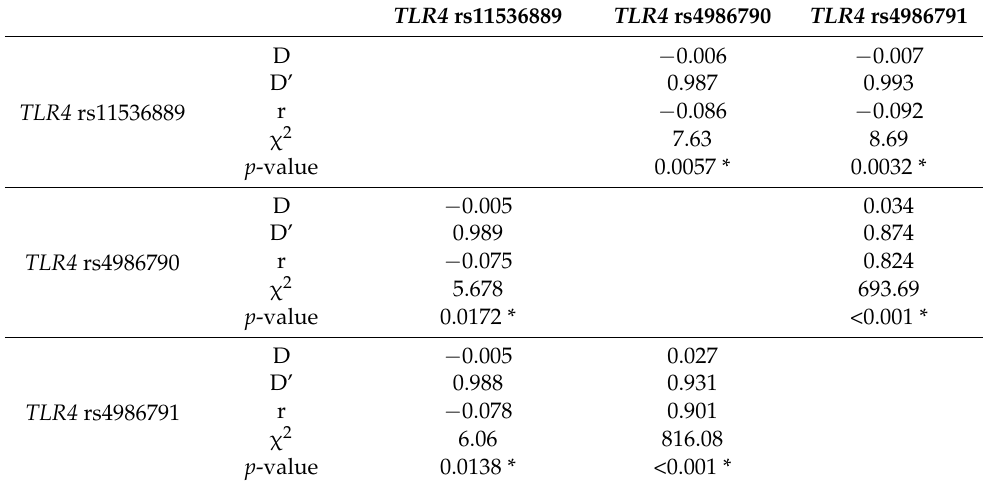
Table 2. Linkage disequilibrium analysis for TLR4 SNPs in AML patients and controls.